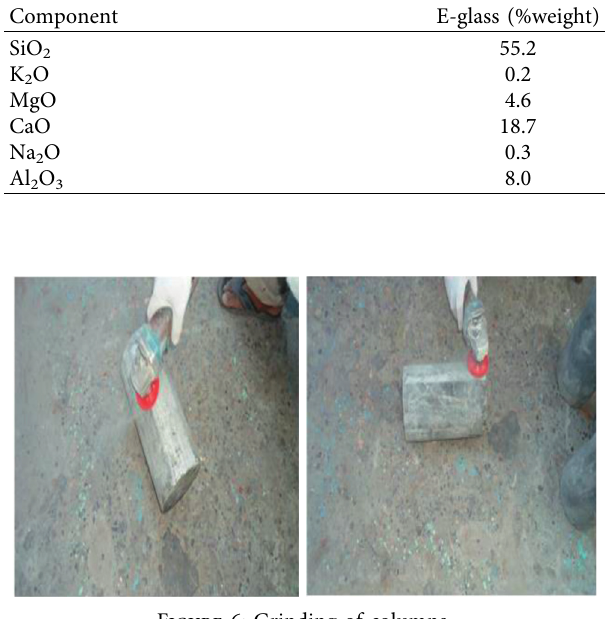
Figure 6: Grinding of columns.